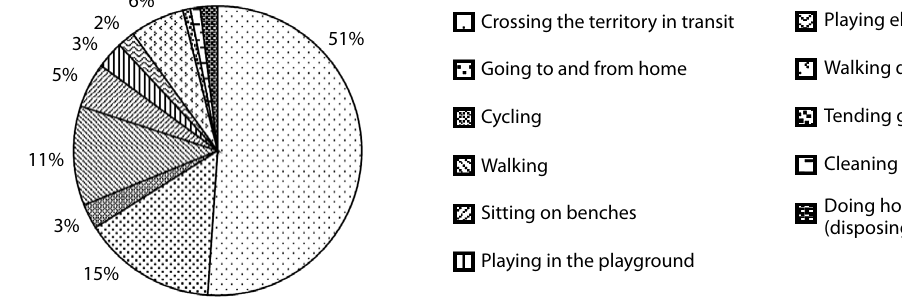
Fig. 9. Type of usage of the vacant inner courtyard